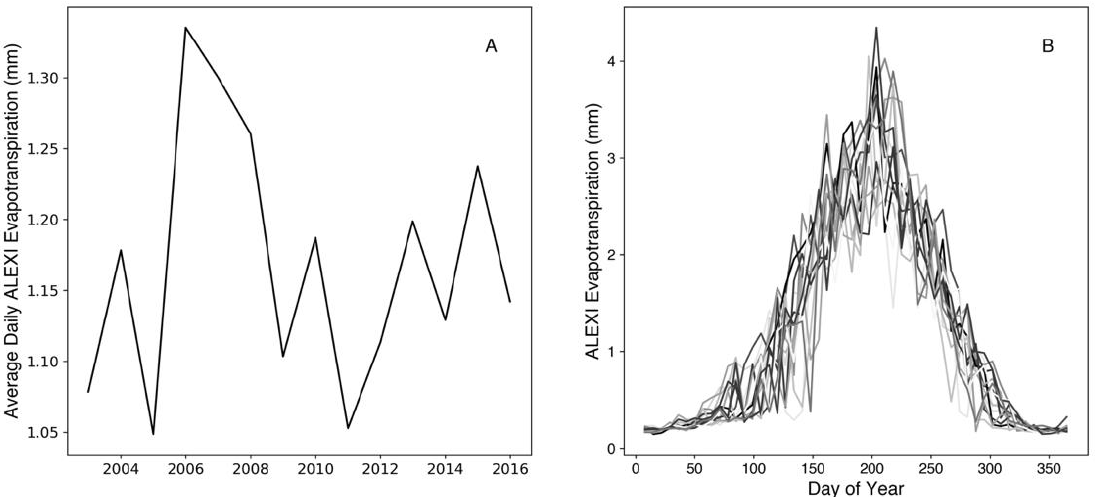
Figure 10. (A) Annual mean daily average actual evapotranspiration modeled by ALEXI data from 2003 to 2017 (B) Daily ALEXI evapotranspiration on different date of year from 2003 to 2017, with darker lines representing more recent years.